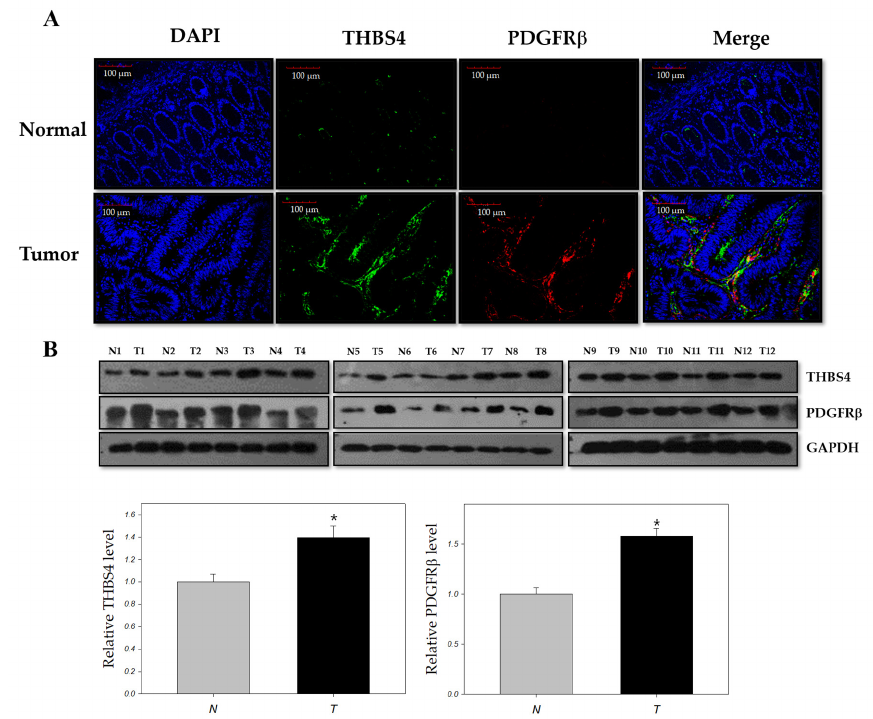
Figure 1. Co-immunofluorescence and immunoblots for Thrombospondin-4 (THBS4) and Platelet-derived growth factor receptor β (PDGFR β ) in normal and tumor tissues of colon cancer patients. ( A ) Immunofluorescence with an anti-THBS4 antibody (green) and anti-PDGFR β antibody (red) on normal (N) and tumor (T) tissues of colon cancer patients. Scale bars = 100 µm. ( B ) Western blot with anti-THBS4 and anti-PDGFR β antibodies on normal and tumor tissues of colon cancer patients. * p < 0.05, compared with normal tissue , t- test .